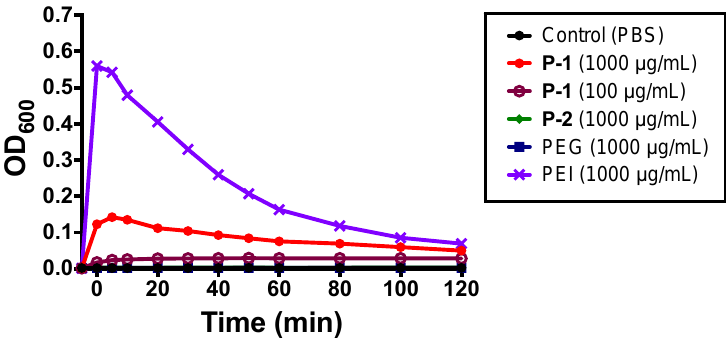
Figure 4. Effect of polymers on planktonic P. aeruginosa solution behavior. Representative data of optical density of P. aeruginosa in TSB incubated with P-1, P-2, PEG, or PEI at 1000 µg/mL, and PBS at room temperature without orbital shaking. The polymers were added into the bacterial suspension at time 0 min.